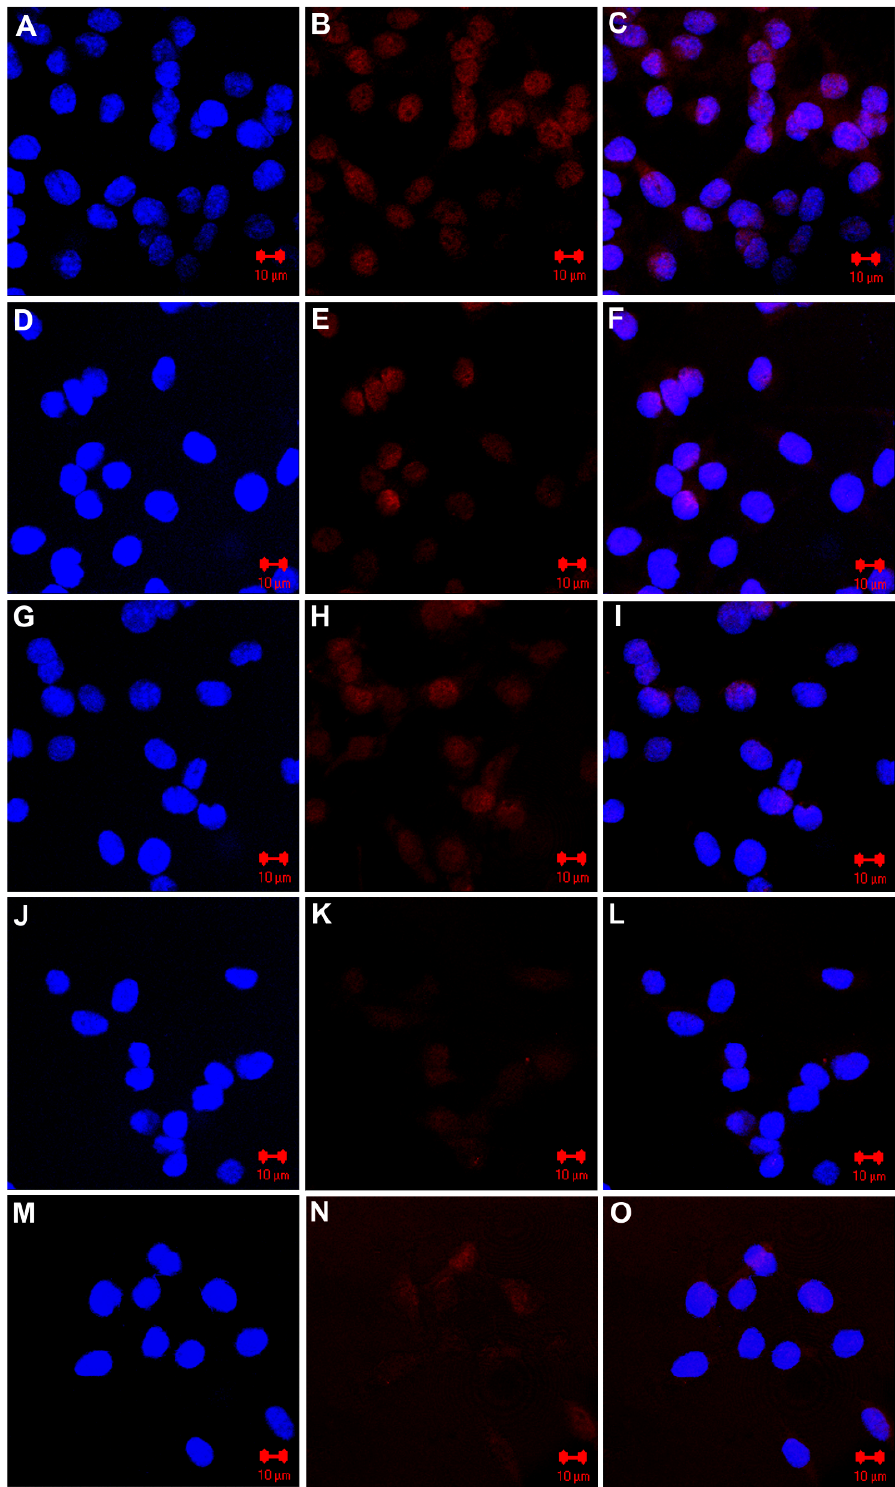
Figure 4. Representative images of fixed M3-EGFR cells obtained by confocal laser scanning microscopy. Incubation with MNT-EGF for 2 h ( A – C ), with EGF-MNT ( D – F ), affibody-MNT ( G – I ), non-targeted MNT ( J – L ), and without MNT ( M – O ), where ( A , D , G , J , M )—nuclei stained with 4 ′ ,6-diamidino-2-phenylindole; ( B , E , H , K , N )—epidermal growth factor receptors revealed by immunofluorescence using Alexa Fluor 647 conjugated antibody; ( C , F , I , L , O )—combined images. Scale bar represents 10 µm.